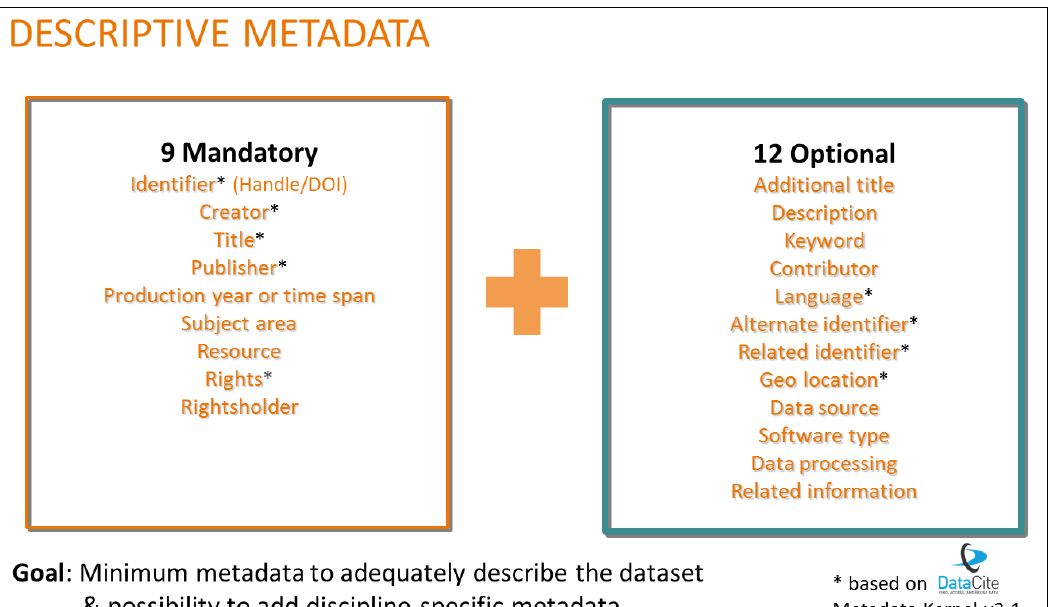
Figure 2. Descriptive RADAR metadata schema including mandatory ( left column ) and optional ( right column ) parameters.